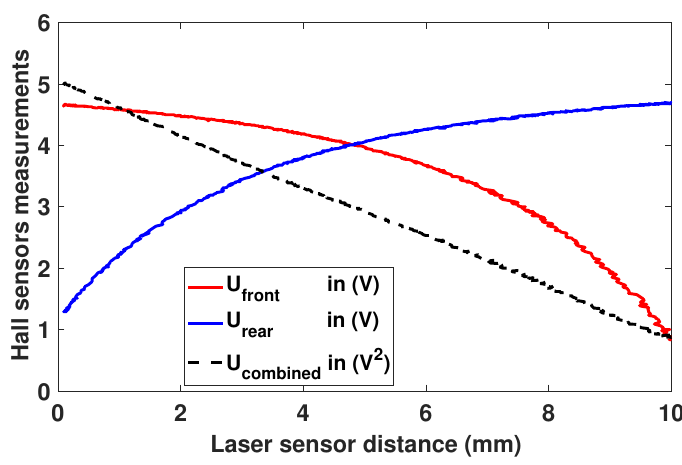
Figure 6. Position sensor measurements: one slow movement.